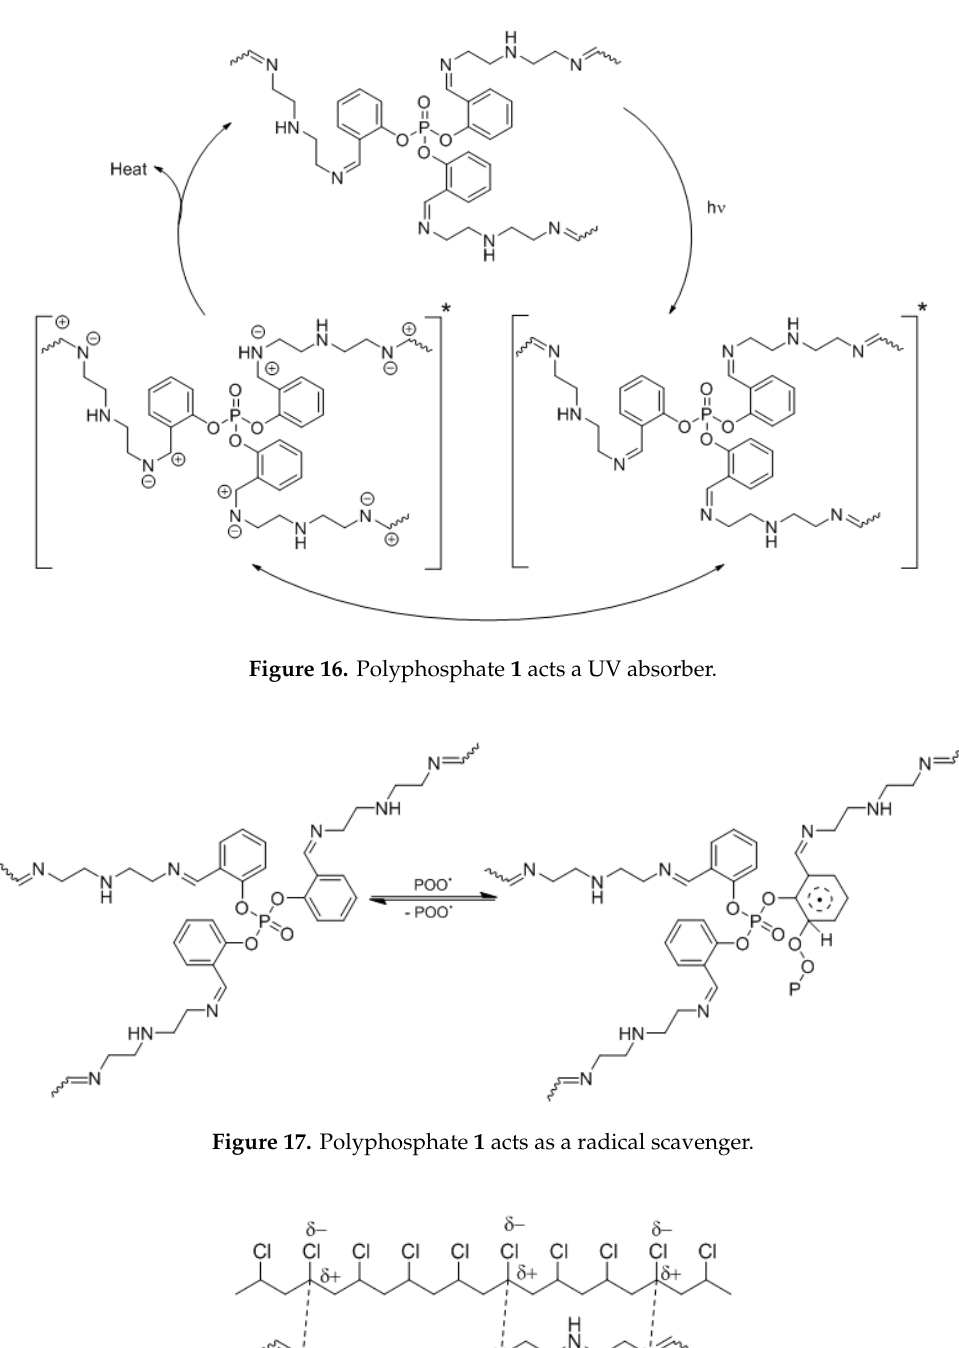
Figure 17. Polyphosphate 1 acts as a radical scavenger.